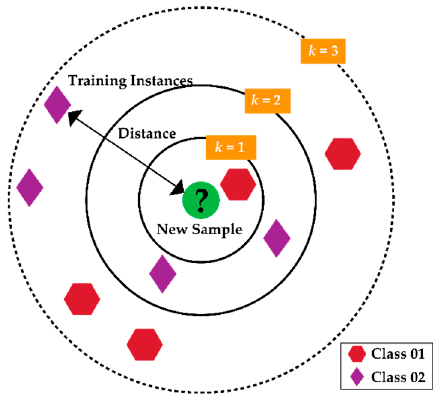
Figure 3. A pictorial illustration of the k-nearest neighbor (k-NN) algorithm.